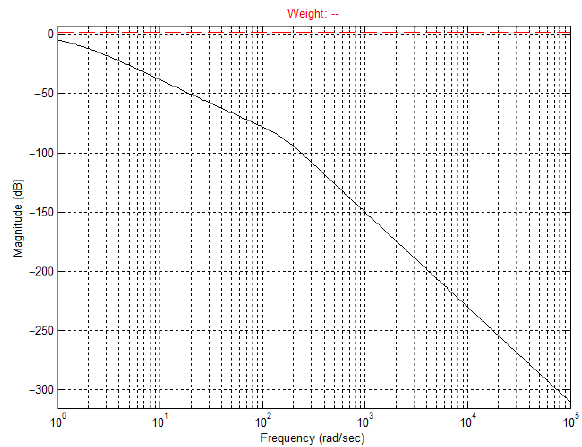
Figure 15. Robust stability in the frequency domain for the vertical plane